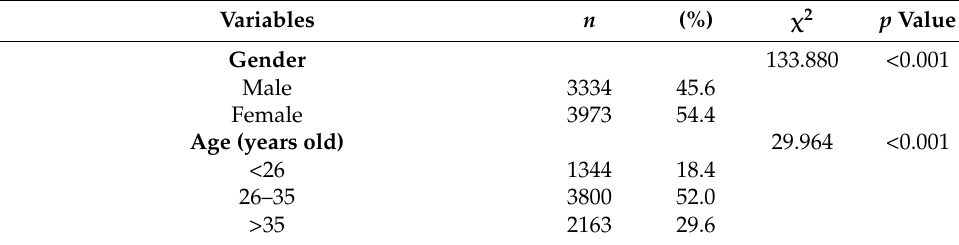
Table 1. Basic characteristics of study